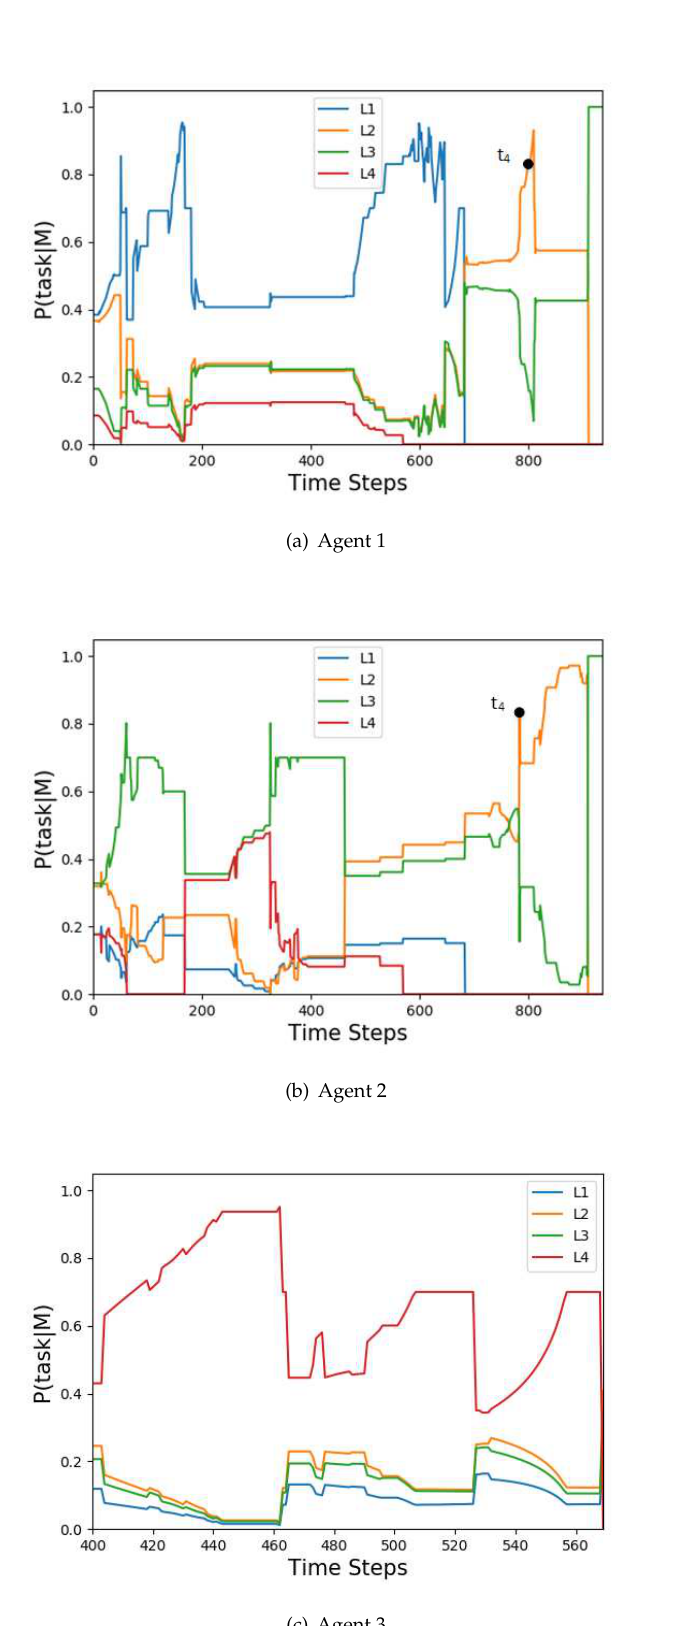
Figure 7. Task probability curves, where L i represents the probability of performing task ϕ i for i ∈ { 1,2,3,4 }